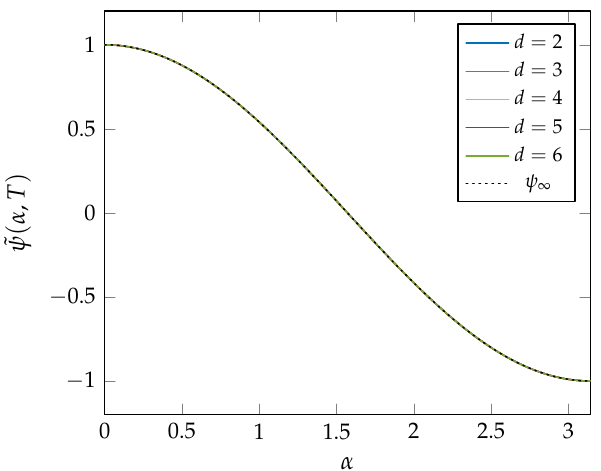
Figure 8. Approximated densities ˜ ψ ( x , T ) , having set T = 1200, ∆ t = 0.3, for increasing degree d of the B-spline basis functions on a grid of size ∆ α = π /10 compared with the stationary